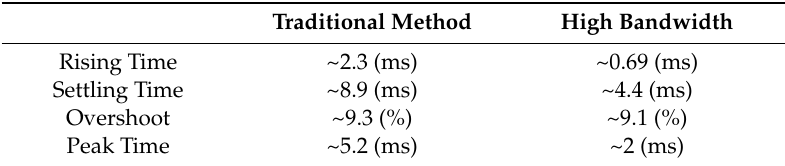
Figure 12. Current loop step response. Table 3. Current loop step response parameter. Table 3. Current loop step response parameter.